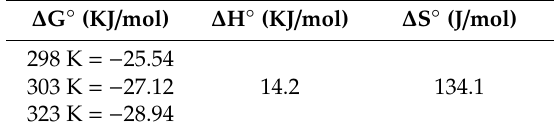
Table 6. Thermodynamics parameters for As(V) adsorption onto FMK.